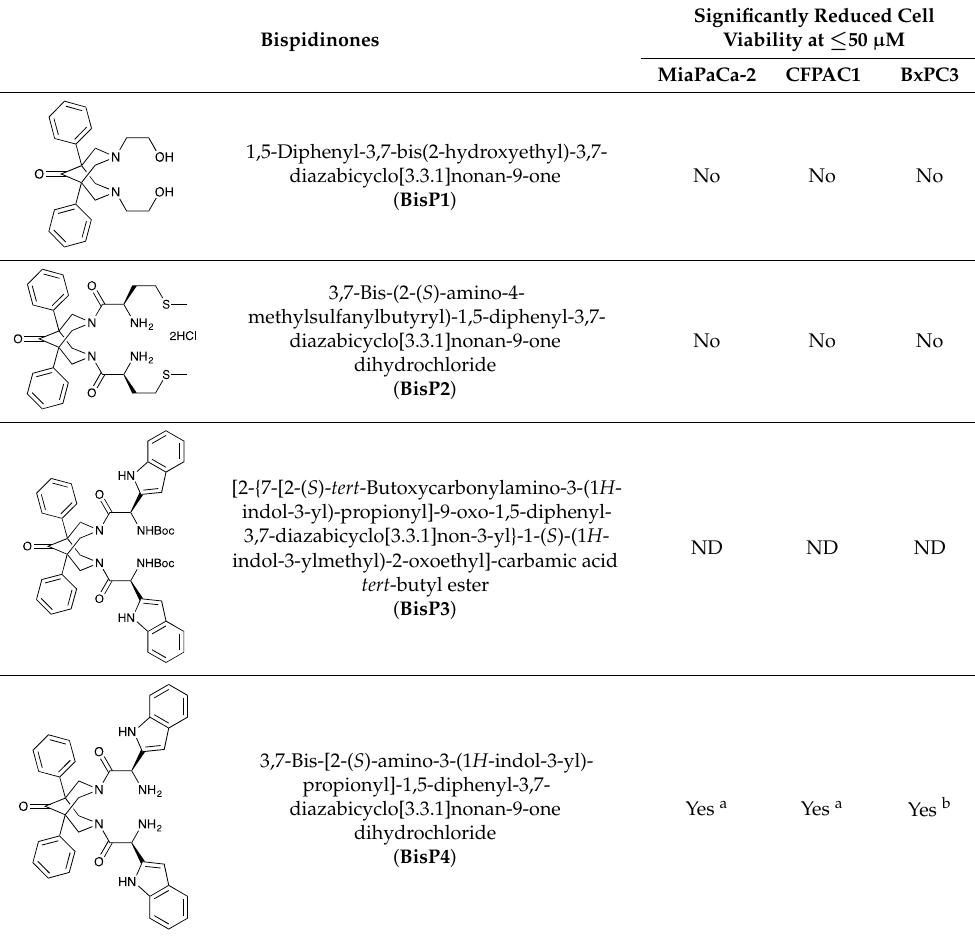
Table 1. Structures of four bispidinone derivatives and their effect on pancreatic cancer cell viability.